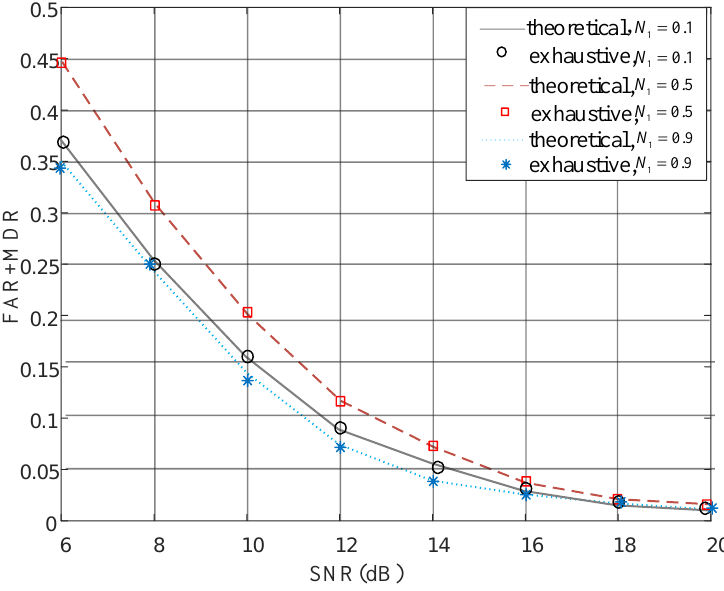
Figure 5. Authentication performance in different relay noise power.